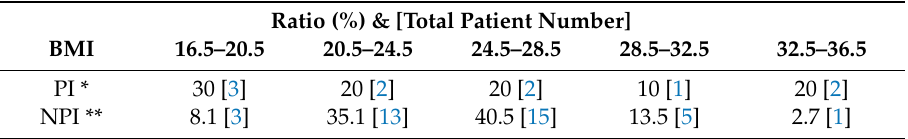
Table 2. Patient number with and without pressure injury classified by 5 different body mass index (BMI) groups.